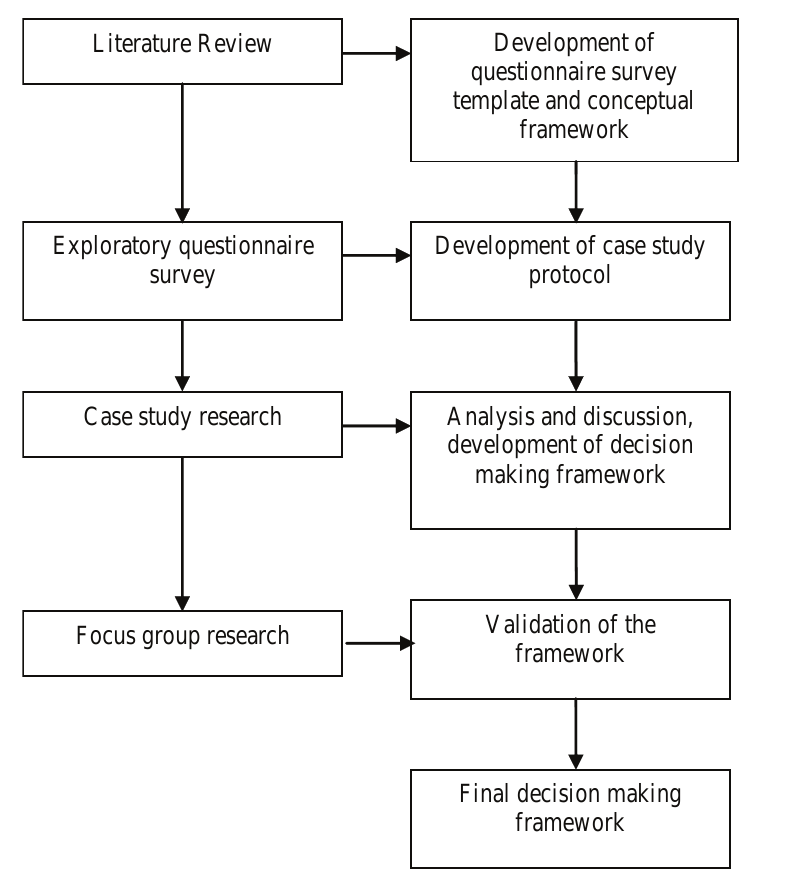
figure 2. research